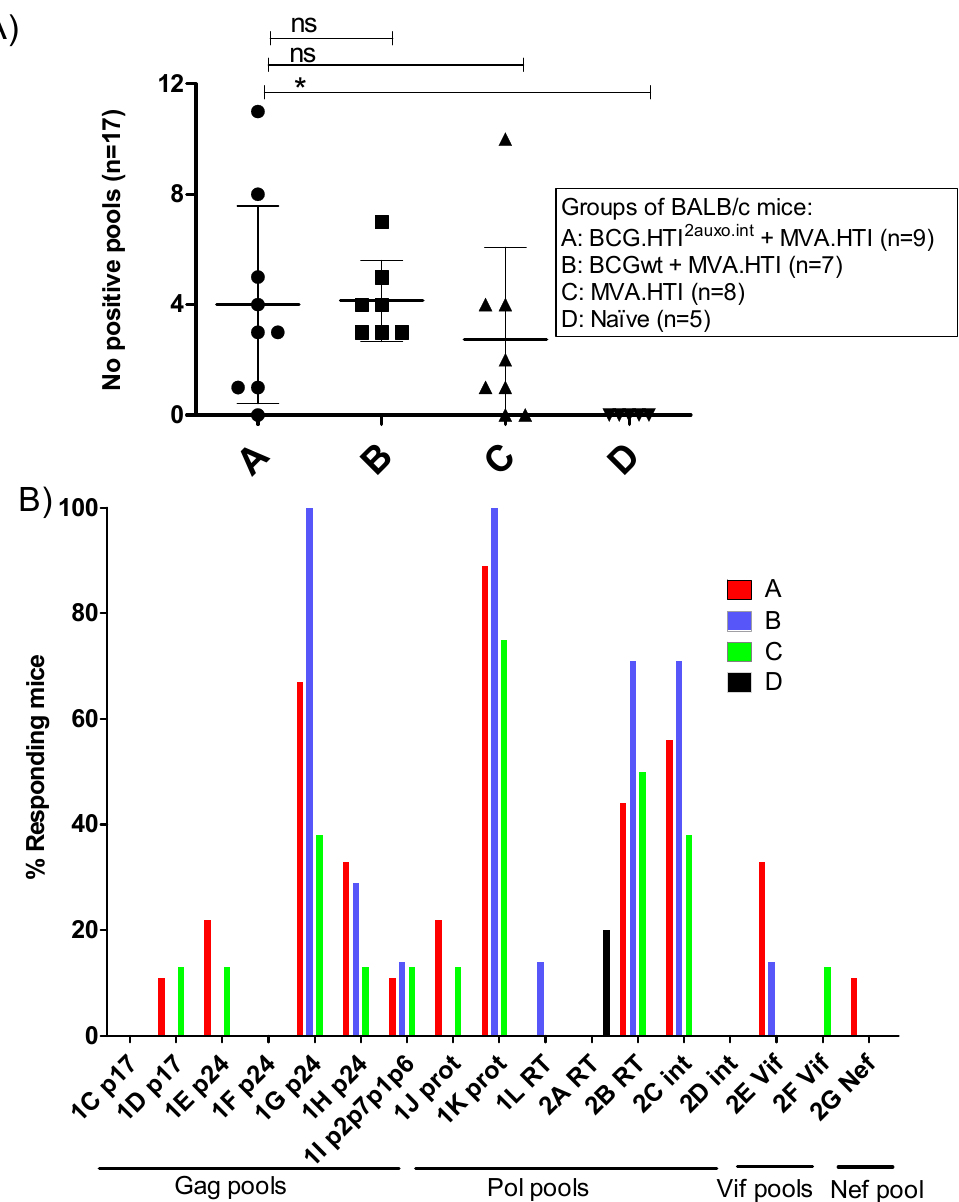
Figure 3. Differential recognition of peptide pools in BCG.HTI 2auxo.int + MVA.HTI immunized BALB/c mice. Adult mice (seven weeks old, n = 5–9/group) were immunized with either 10 6 cfu of BCG.HTI 2auxo.int (id) and boosted with MVA.HTI (10 6 pfu, im) after five weeks (group A), or with 10 6 BCGwt (id) and boosted with MVA.HTI (10 6 pfu, intramuscular) after five weeks (group B), or only immunized with MVA.HTI (10 6 pfu, intramuscular) at week five (group C), or left unimmunized (group D). Two weeks post-boost, mice were sacrificed, splenocytes were isolated for IFN- γ ELISPOT analysis, and the numbers of reactive peptide pools (total n peptide pools = 17) were compared for each mouse. ( A ) The number of reactive pools per mouse. Statistics were performed using the non-parametric Kruskal–Wallis test adjusted for multiple comparisons, * p < 0.05. ( B ) The percentage of reactive mice in each group according to peptide pool and HIV-1 gene location. ns: not significant.